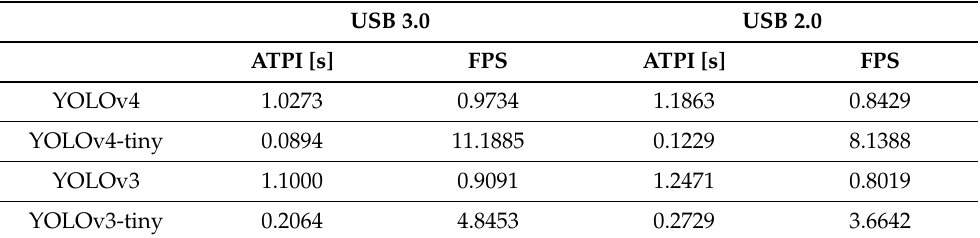
Table 5. Performance result for the NCS2 accelerator with two USB interface options. ATPI stands for average time per inference, FPS is frames per second.